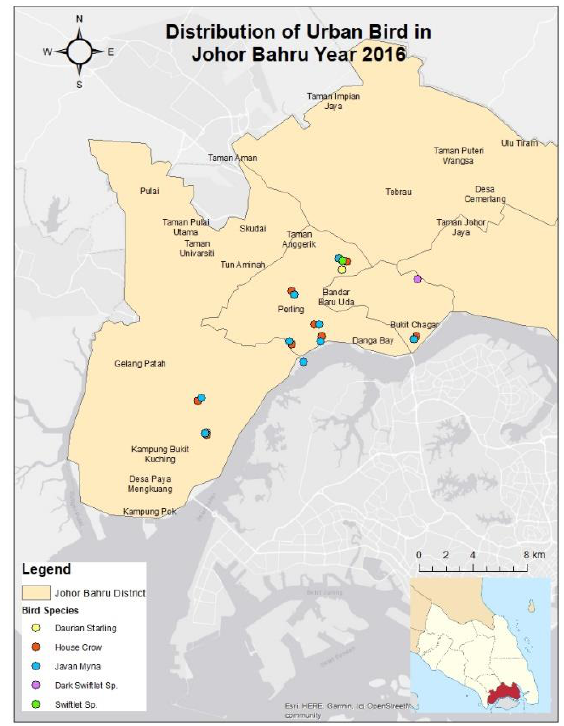
Figure 2 Distribution of urban bird by species in year